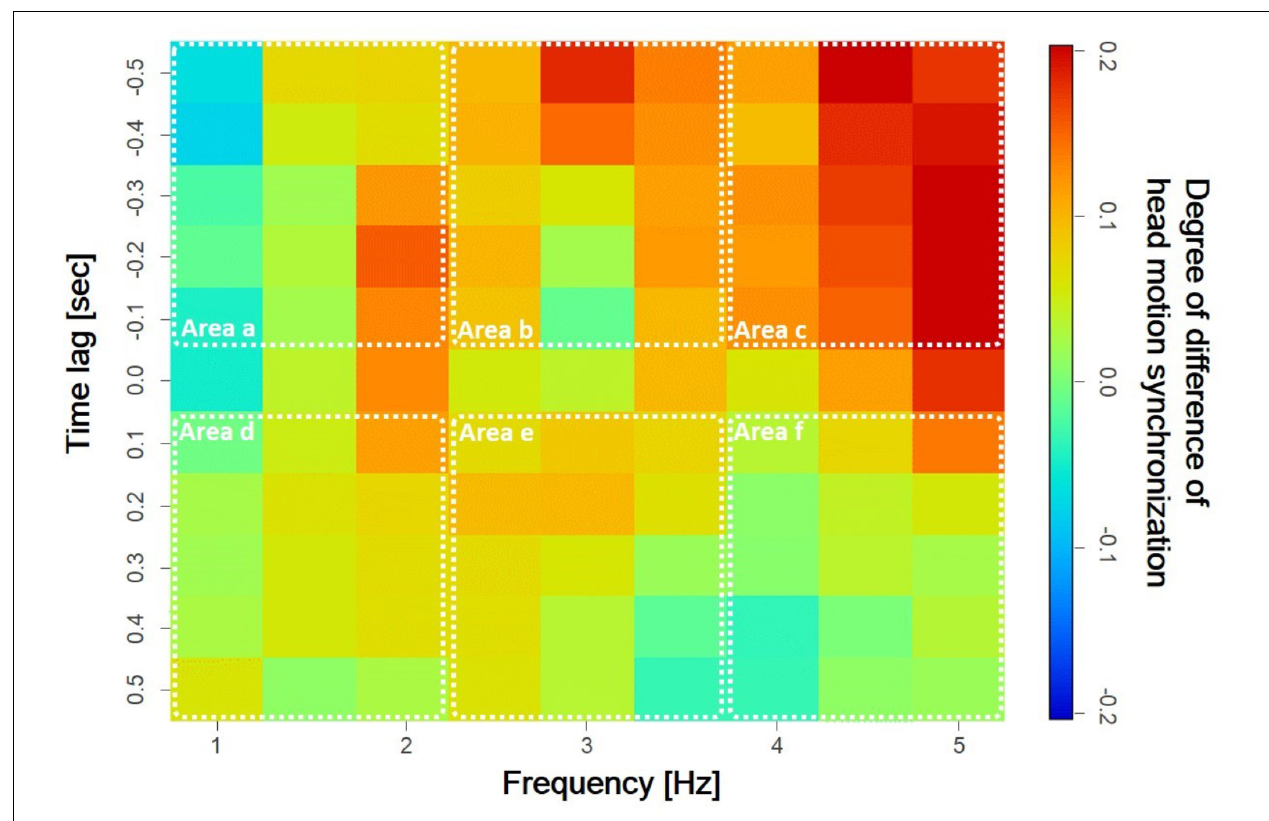
FIGURE 6 | Difference in incidence of head motion synchronization between low and high empathy conditions. The dashed line shows the six areas of comparison between high and low empathy conditions.